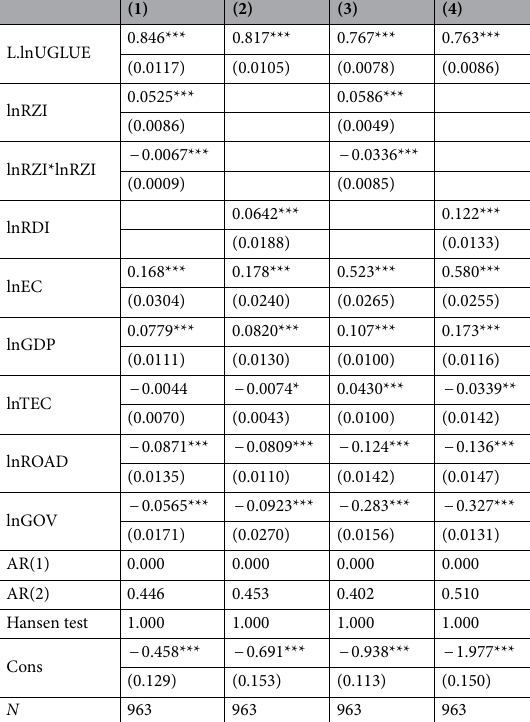
Table 4. Estimation results of robustness test.